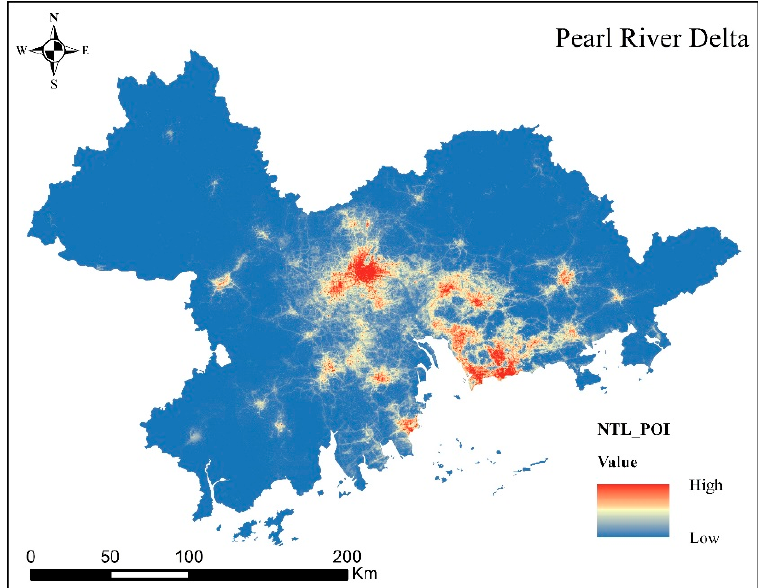
Figure 9. Fusion results of NTL data and POI data in PRD.